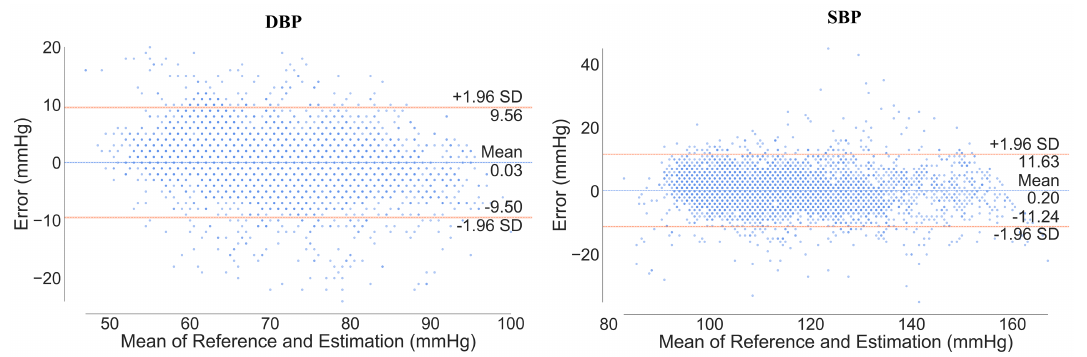
Figure 11. Bland–Altman plot of DBP and SBP. The orange line denotes the limit of agreement (LOA) and the blue line denotes the mean of difference error between reference and